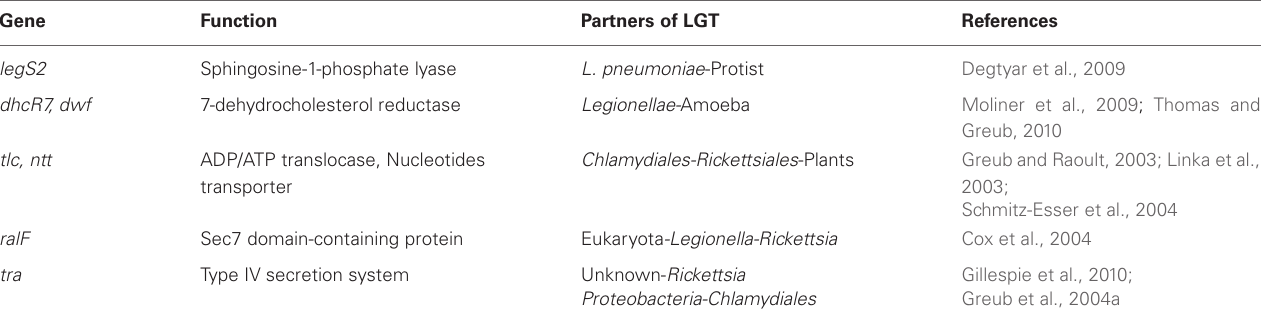
Table 5 | Examples of lateral gene transfer with amoeba-resisting bacteria. Gene